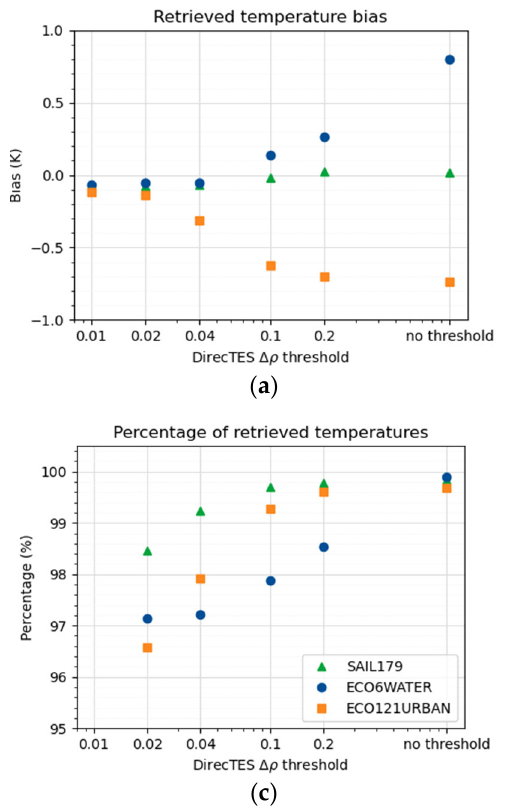
Figure 12. Bias ( a ), RMSE ( b ) and retrieved percentage ( c ) obtained with DirecTES and ∆ T thresh = 3 K, adding VNIR-SWIR information. These results are given as a function of the reflectance threshold Δρ to select emissivity spectra based on their VNIR-SWIR behavior.